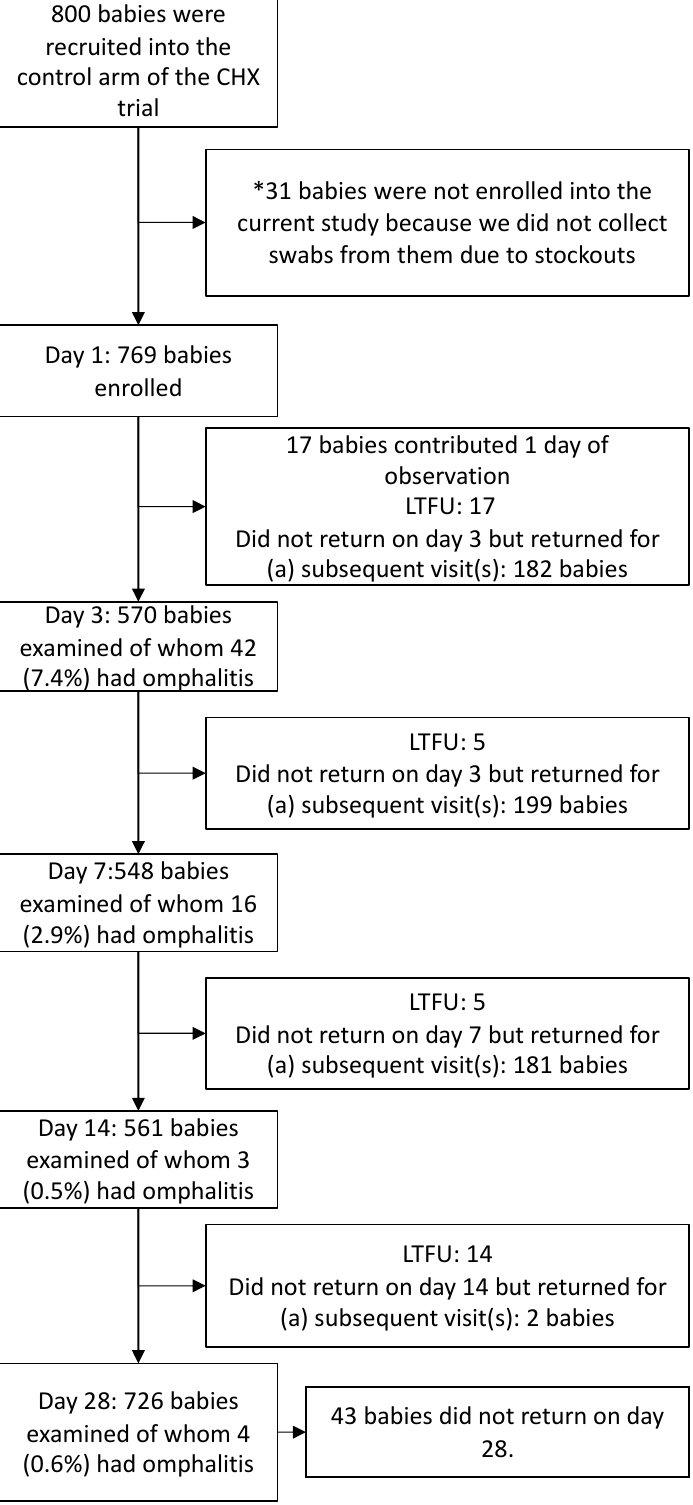
Figure 1. Flow chart of participants included in the study. MLFTU: Lost to follow-up; babies that never returned for the subsequent scheduled visits. * The missing data resulted from stockouts of swabs that were spread out during the course of the study.